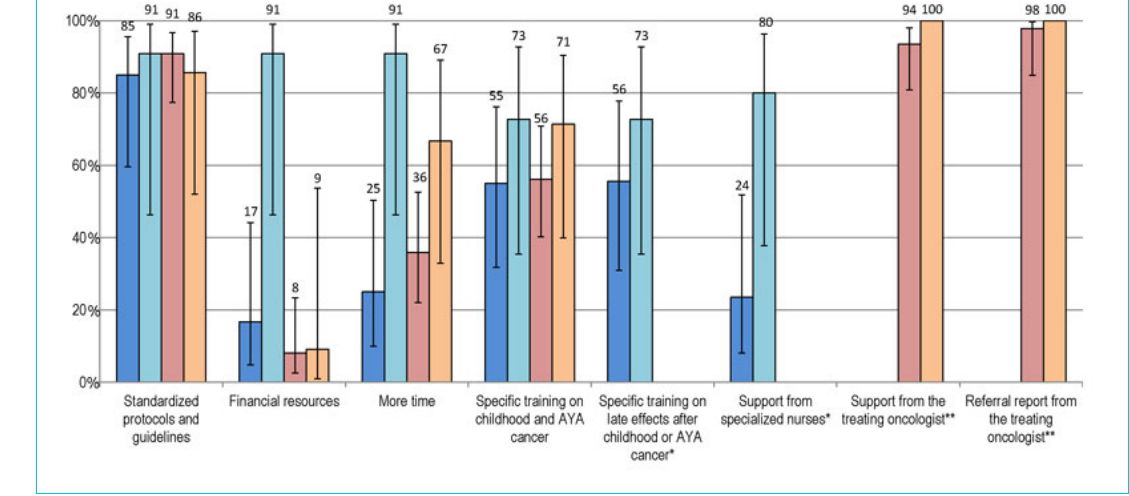
Figure 4: Additional resources desired by physicians to provide optimal follow-up care, stratified by medical specialisation.The results are stratified by type of medical specialisation. The bars and values at the top of the bars represent the proportion (%) of physicians who con- firmed to desire the respective resource, with 95% confidence intervals. *The corresponding question was put only to medical and paediatric oncologists. **The corresponding question was put only to general practitioners and paediatricians.Dark blue = medical oncologists (n = 22); light blue = paediatric oncologists (n = 11); Pink = general practitioners (n = 48); orange = paediatricians (n =